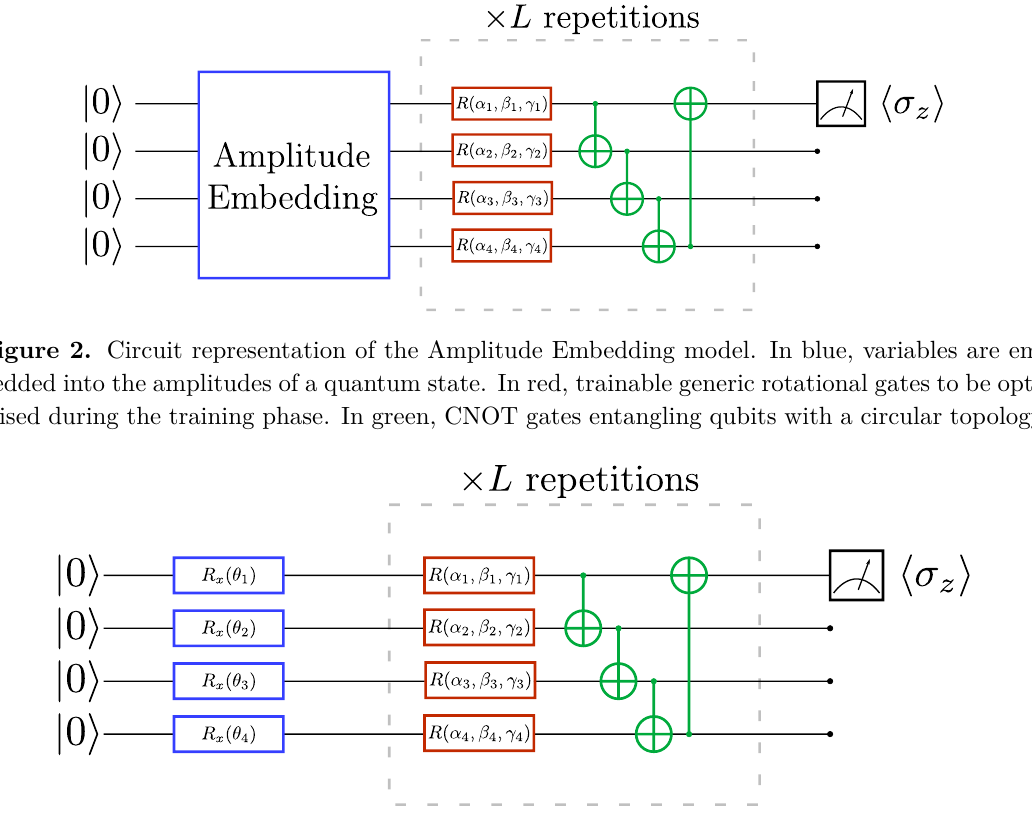
Figure 3. Circuit representation of the Angle Embedding model. In blue, x -axis rotational gates used to embed the variables into the quantum circuit. In red, trainable generic rotational gates to be optimised during the training phase. In green, CNOT gates entangling qubits with a circular